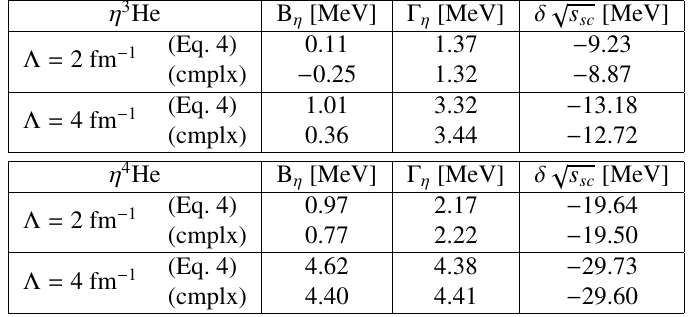
Table 1. Comparison of self-consistent SVM calculations using two di ff erent width Γ η evaluations - the mean-value approximation (Eq. 4) and the complex eigenvalue problem (cmplx) approach. Calculations were performed for the Minnesota NN potential with Coulomb force and the GW model. √ s sc are shown as The η binding energy B η and self-consistent energy δ